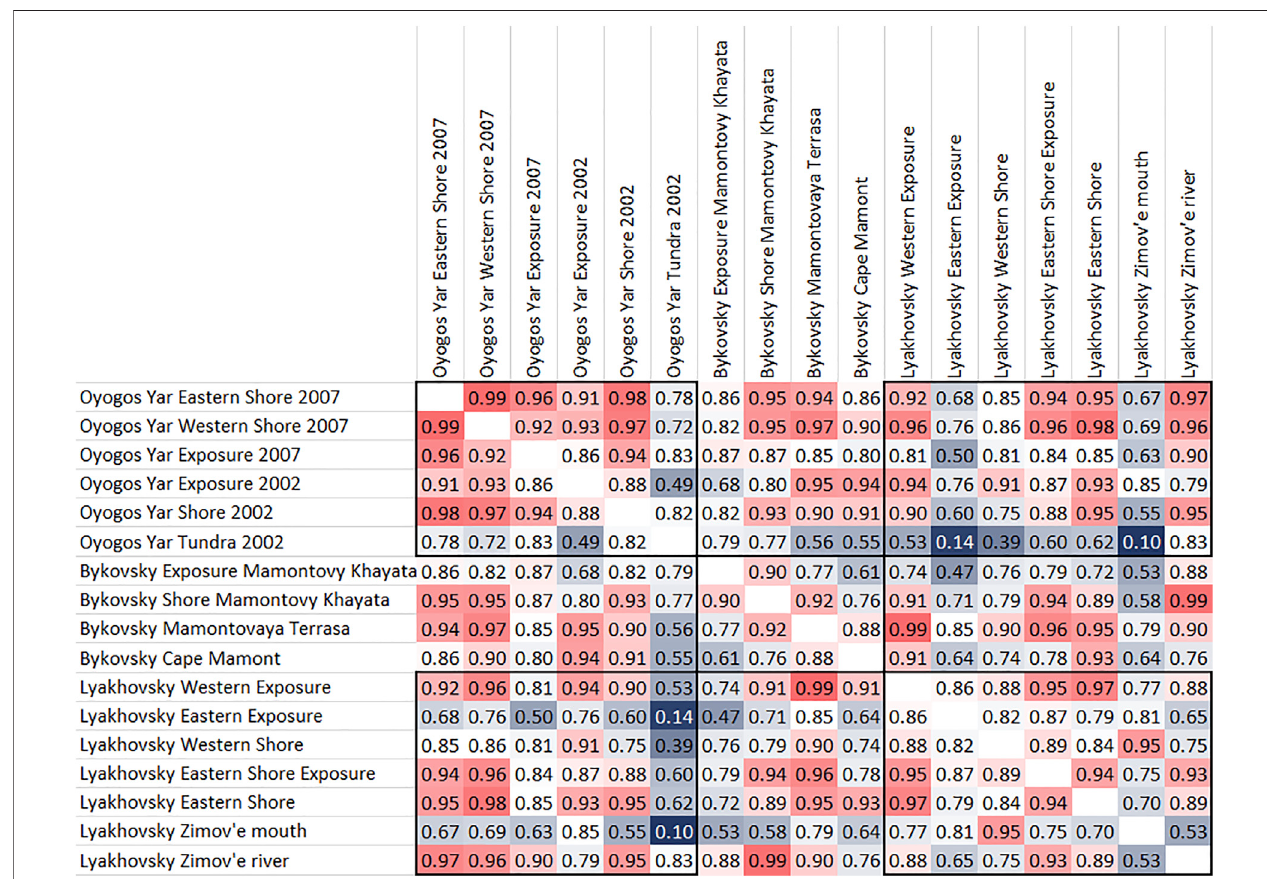
FIGURE 9 | The Pearson correlation coef fi cients for the different sampling sites of the collections from Oyogos Yar 2007 + 2002, Bykovsky Peninsula 1998, and Bol ’ shoy Lyakhovsky Island 1999.